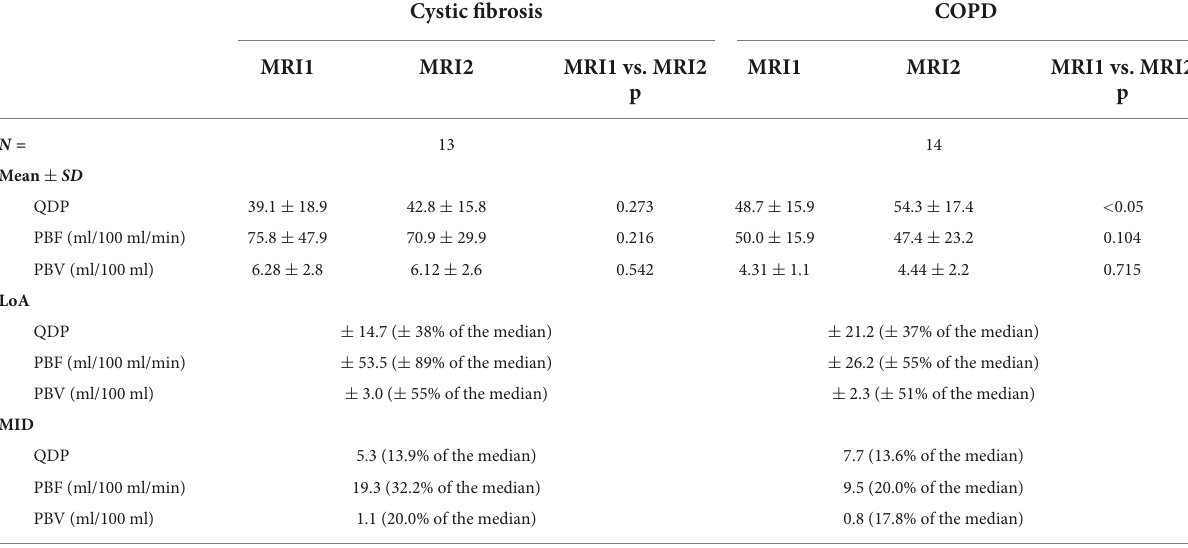
TABLE 2 Reproducibility of quantitative pulmonary perfusion parameters in clinically stable cystic fibrosis and COPD